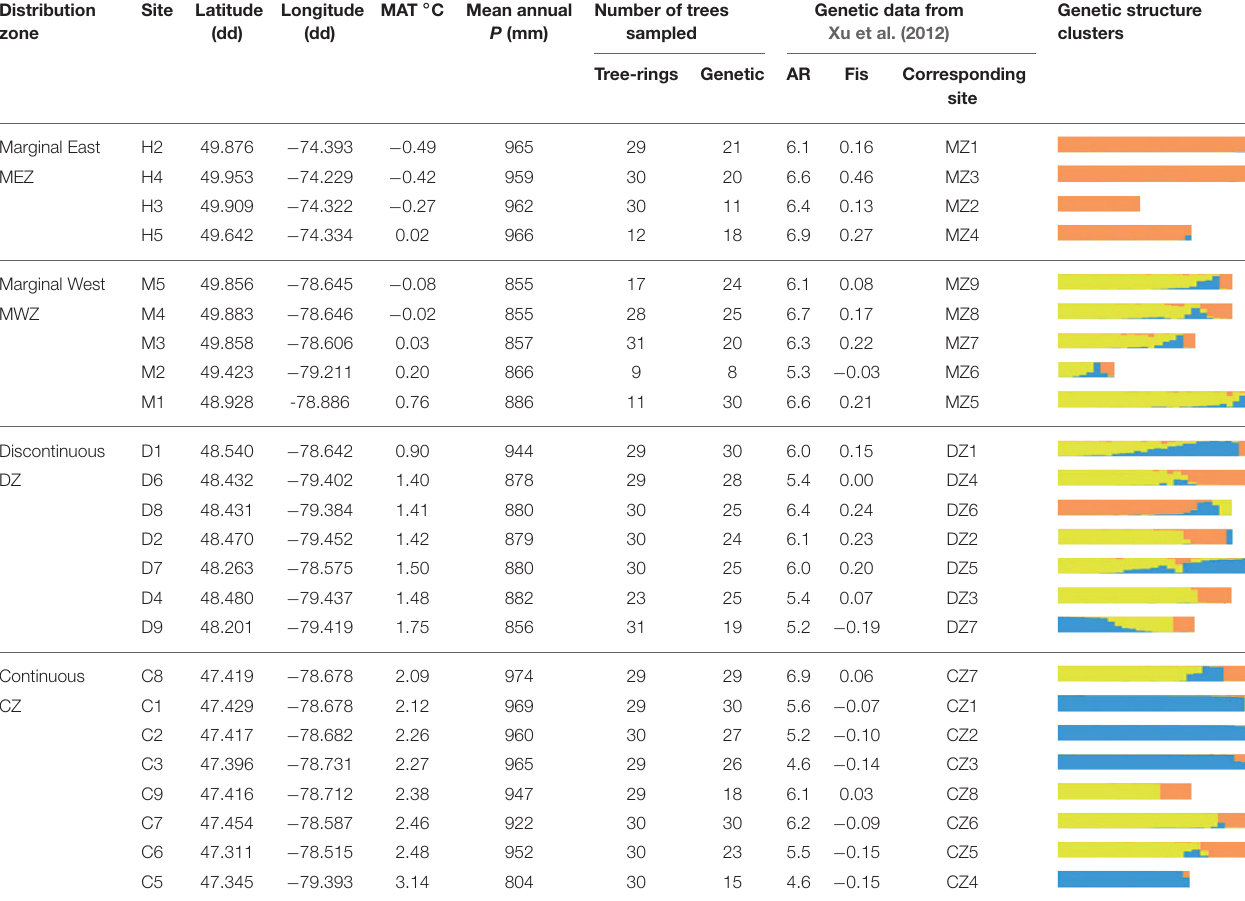
TABLE 1 | Geographic, climatic, and neutral genetic features of the Thuja occidentalis sampling sites. Distribution